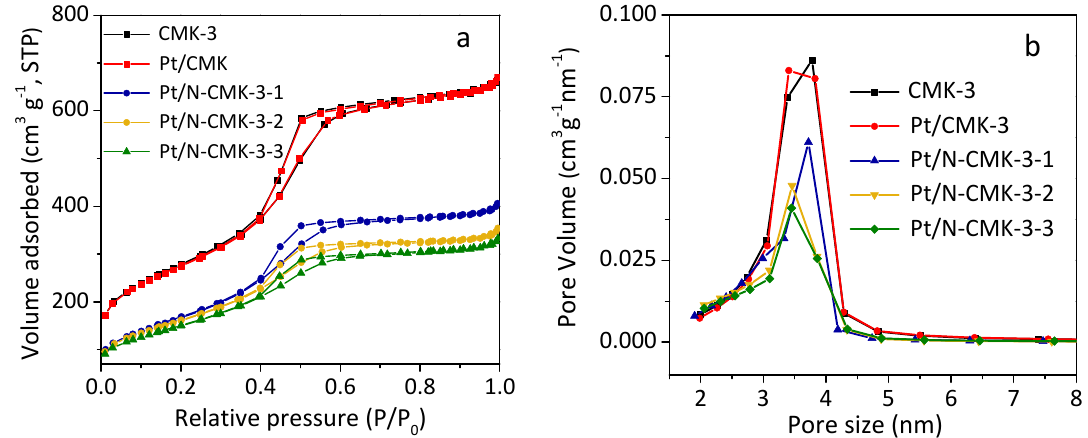
Figure 1. ( a ) N 2 sorption isotherms and ( b ) pore size distributions of the CMK-3, Pt / CMK-3, and Pt / N-CMK-3-x (x = 1, 2, and 3) samples.